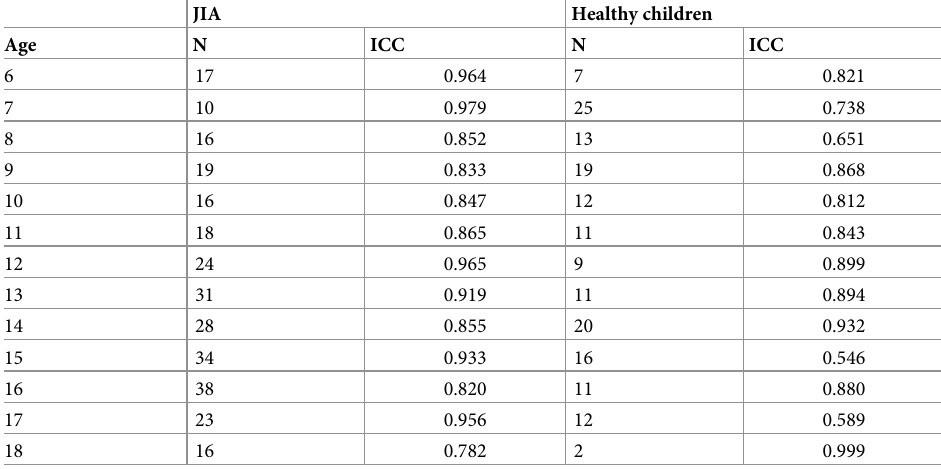
AMVBF: anterior maximum voluntary bite force; ICC: intra-class correlation coefficient. The ICC was calculated by using data for AMVBF 1,2,3 .